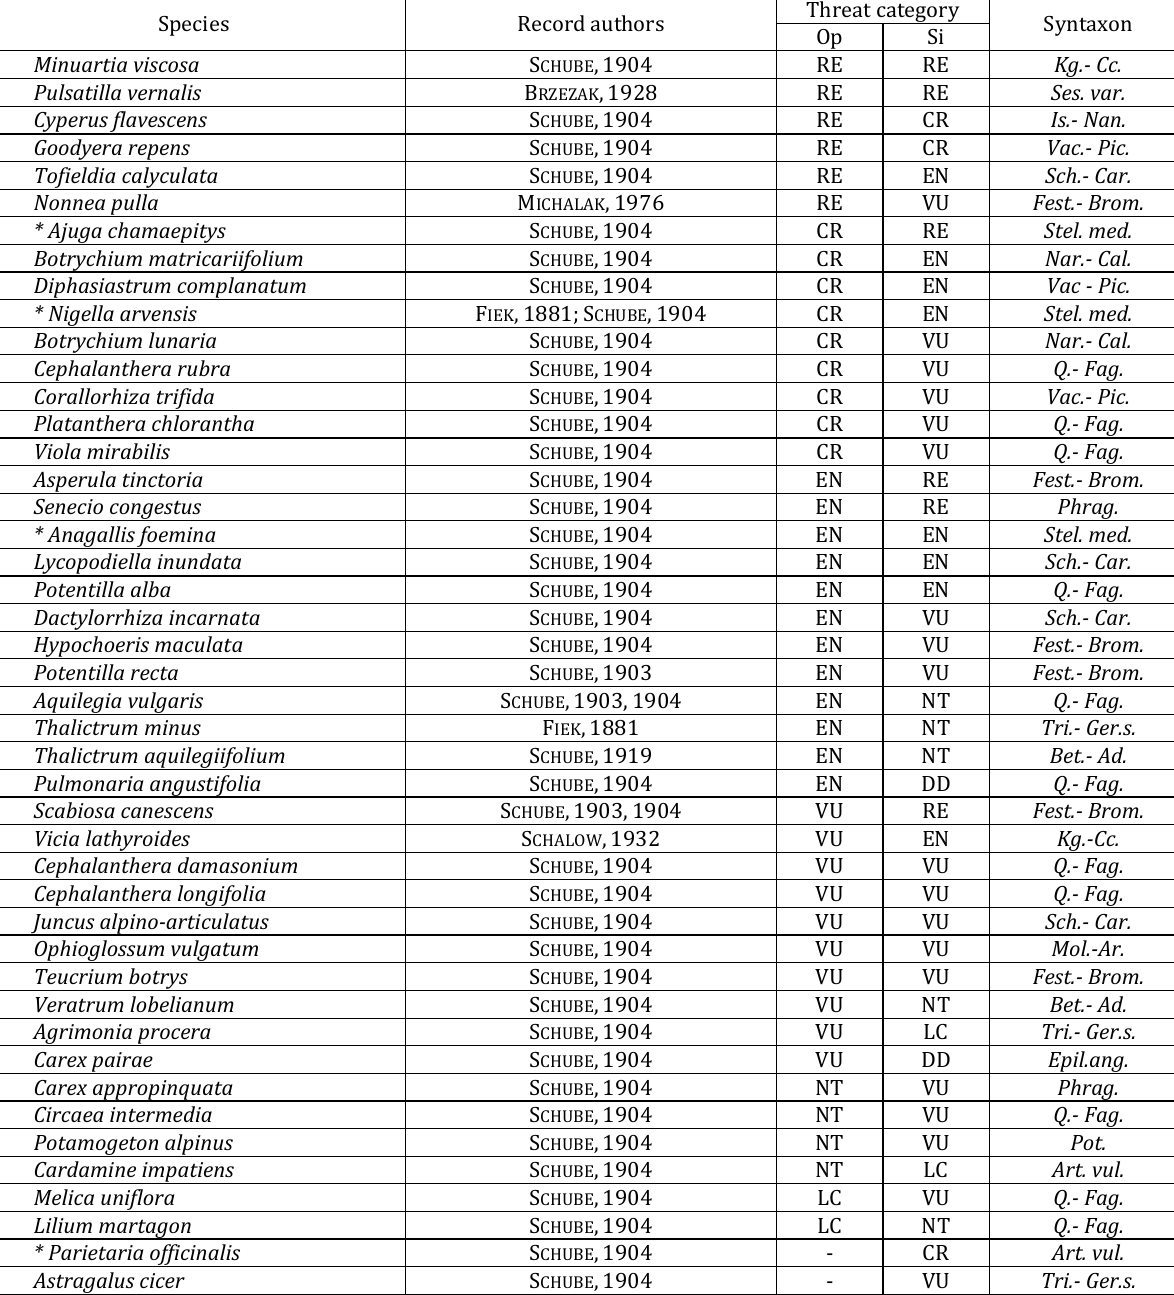
Table 1. Species not confirmed after 1945 in Strzelce